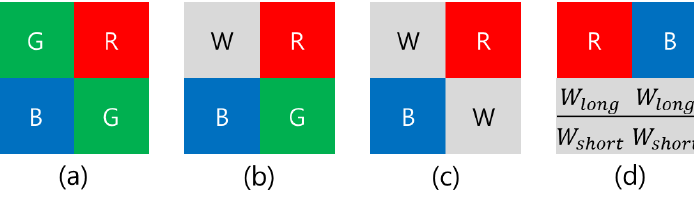
Figure 1. Examples of color filter array (CFA) patterns: ( a ) Bayer; ( b ) red–green–blue–white (RGBW); ( c ) red–white–blue (RWB); and ( d ) RWB with double-exposed W channel.